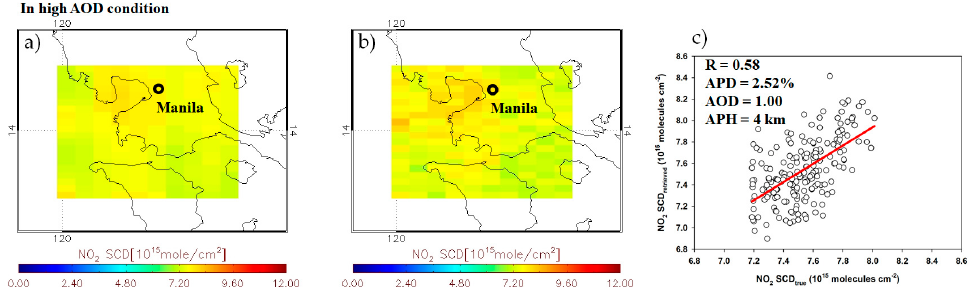
Figure 12. ( a ) True NO 2 SCDs, ( b ) retrieved NO 2 SCDs and ( c ) a scatter plot of true and retrieved NO 2 SCDs using the pixel co-adding method under high-AOD conditions. (Slant column density (SCD) and aerosol optical depth (AOD)).